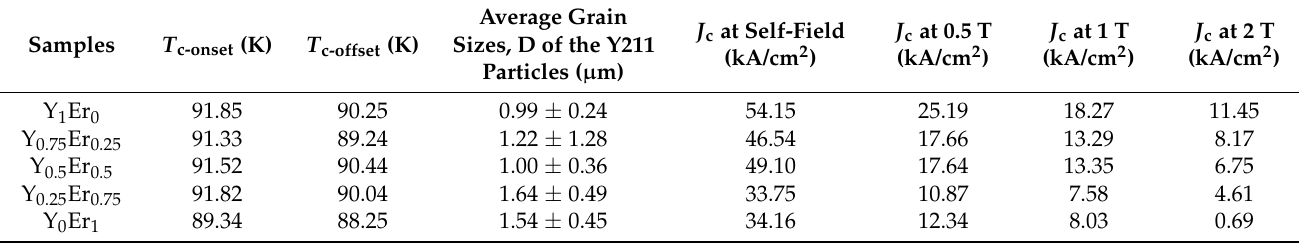
Table 2. Summary of T c-onset , T c-zero , average particle sizes of the Y211, and J c values at self-field, 0.5, 1.0, and 2 T of IG processed Y123 produced with different ratio of liquid phase. Samples